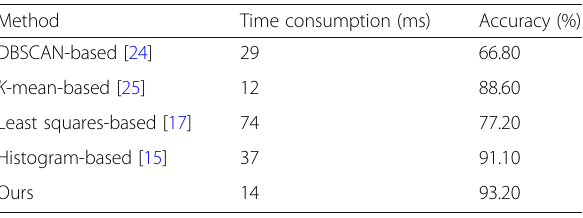
Table 3 Summary of experimental results on time consumption and